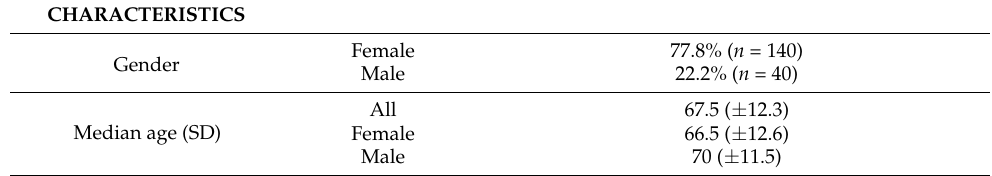
Table 1. Clinicopathological characteristics of gallbladder cancer (GBC)